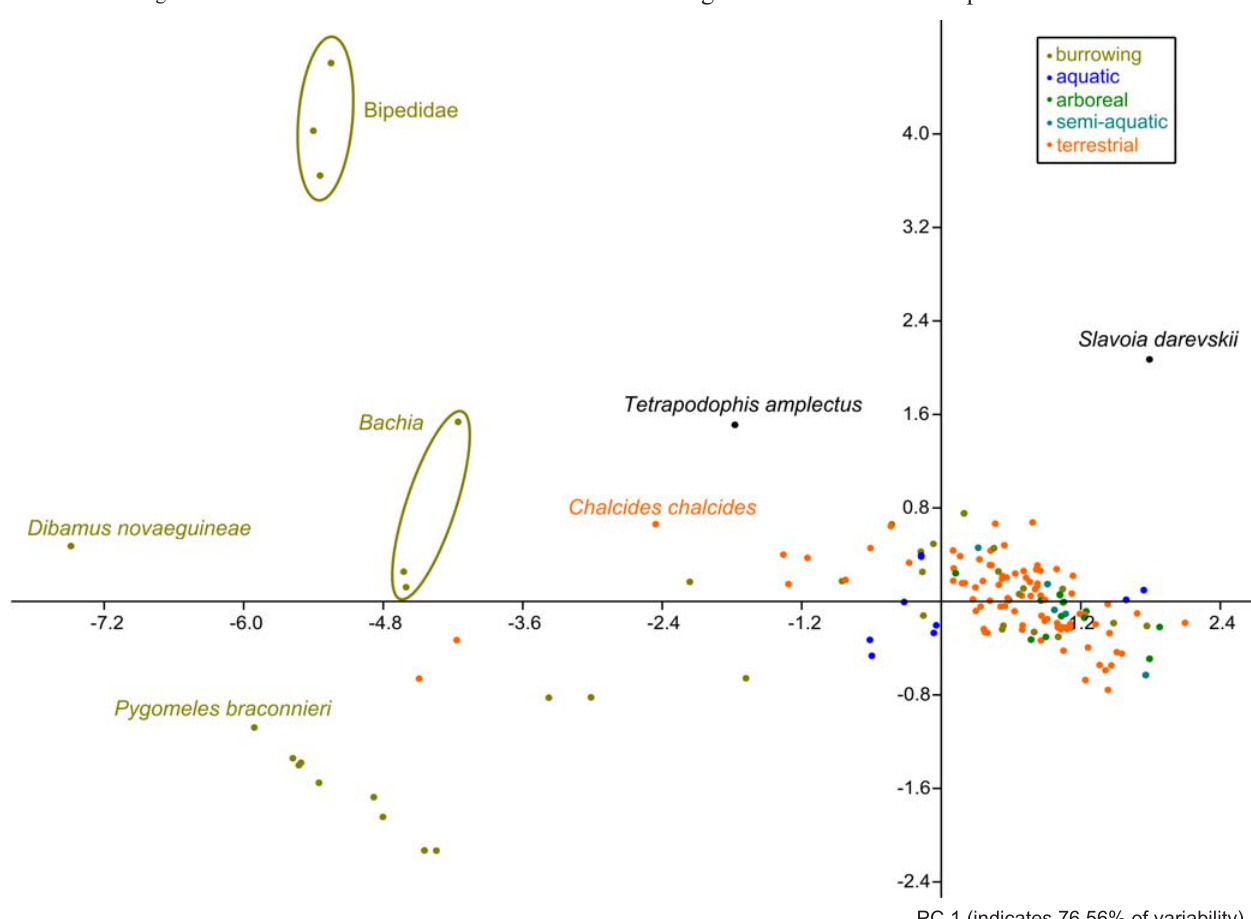
PC 1 (indicates 76.56% of